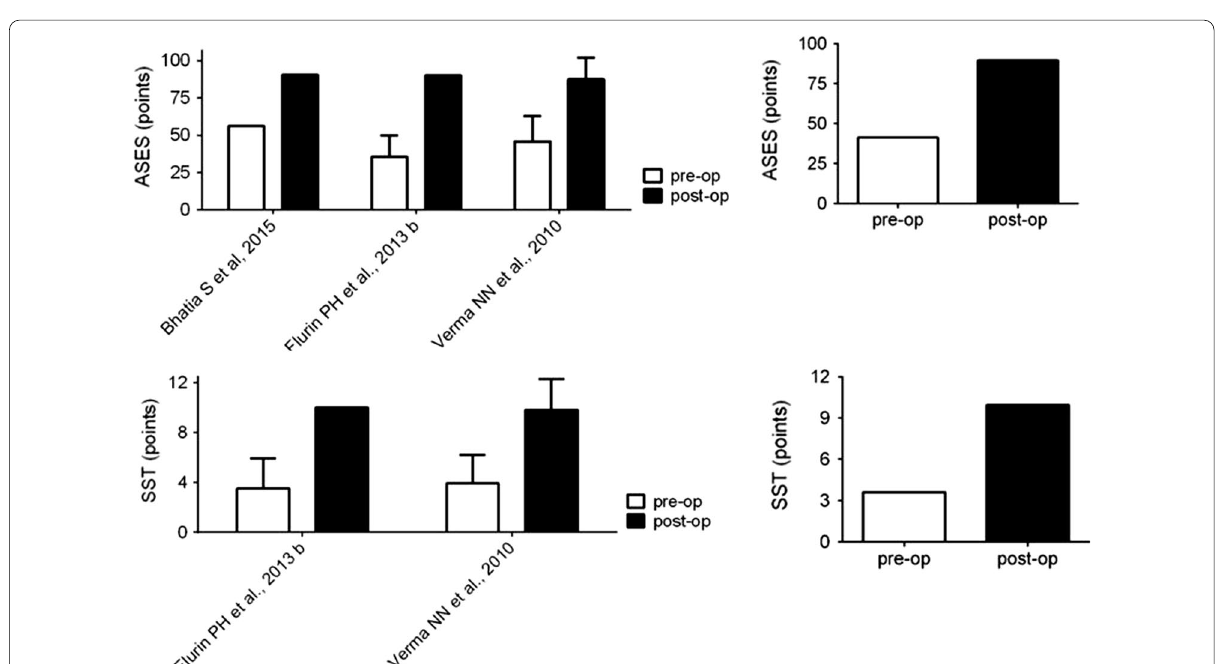
Fig. 4 Comparison of ASES and SST in pre- and postoperative populations. Left: mean ASES and SST values reported in the analyzed studies; Right: weighted average value of ASES and SST. ASES, American Shoulder and Elbow Surgeons Score; SST, Simple Shoulder Test; pre-op, preoperative; post-op,